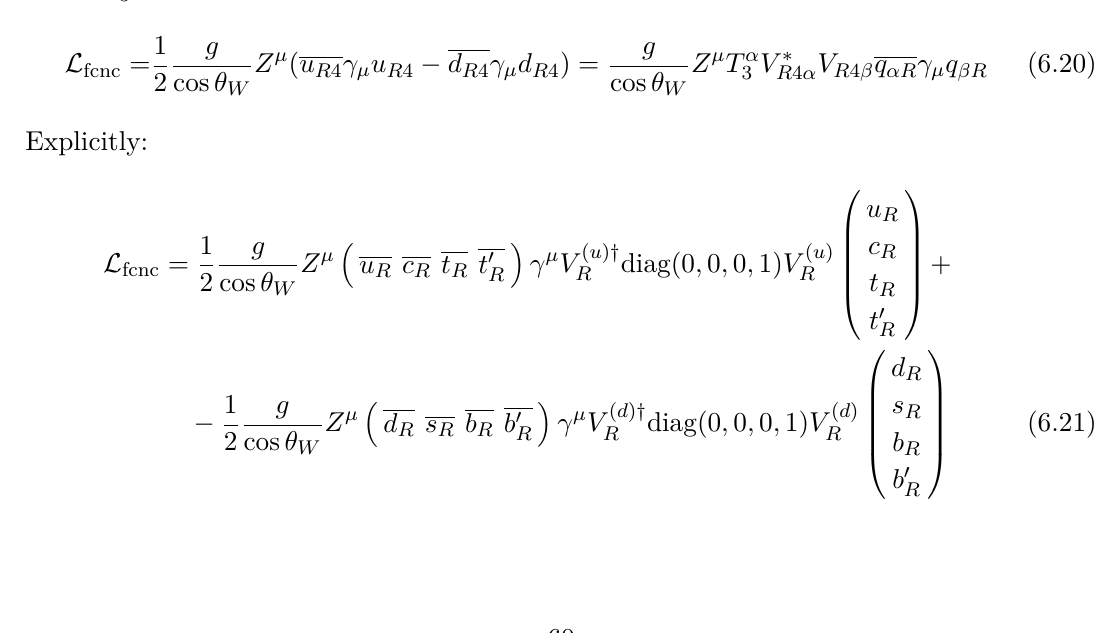
Figure 17 . Explanation of the anomalies of V us determinations in the SM extension with an extra vector-like isodoublet ( b 0 , t 0 ) . The three different determinations V A eqs. (2.3), (2.13), (2.14) are obtained from the experimental results in eqs. (2.3), (2.5), (2.10) using CKM unitarity in the context of the SM. However, in presence of an extra isodoublet mixing with SM families, the three observables would correspond to the couplings in eqs. (6.13), (6.14), (6.15). V = − 0 . 93(27) × 10 − 3 with V Rud 0 . 97375(29) , the solution is V V = 0 . 22441(35) Lus